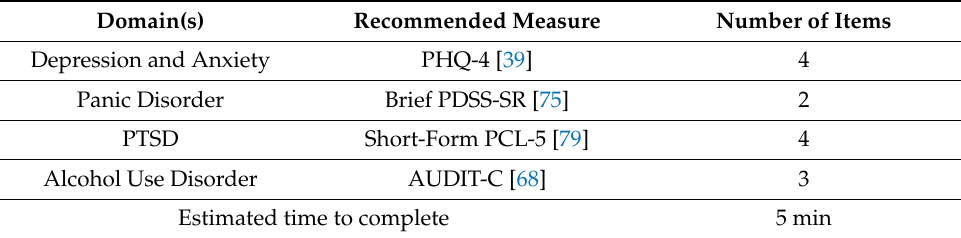
Table 3. Recommended short-form screening battery for PSP.